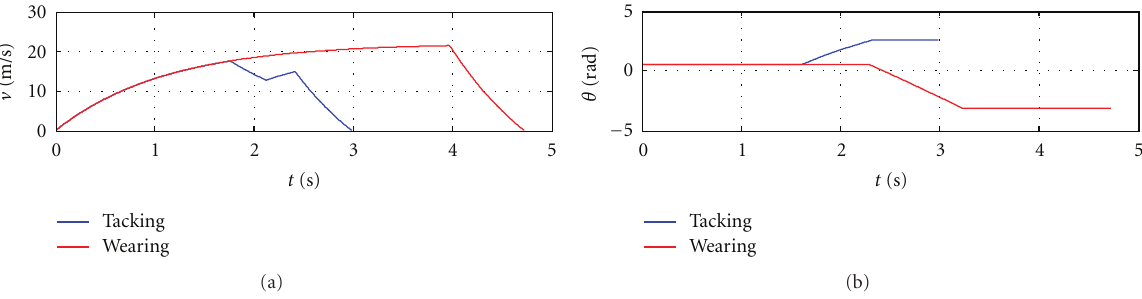
Figure 8: Vehicle velocity and heading angle for tacking and wearing maneuvers. (a) Vehicle velocity and (b) heading angle.